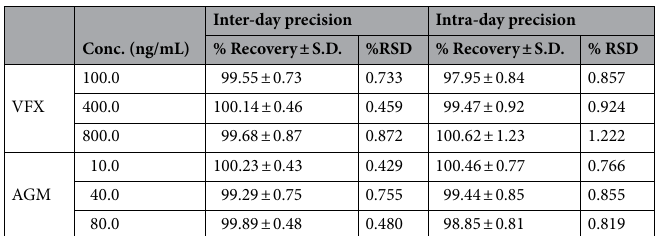
Table 2. Precision data for the determination of VFX and AGM by the proposed method. N.B. Each reading is the average of three separate determinations.